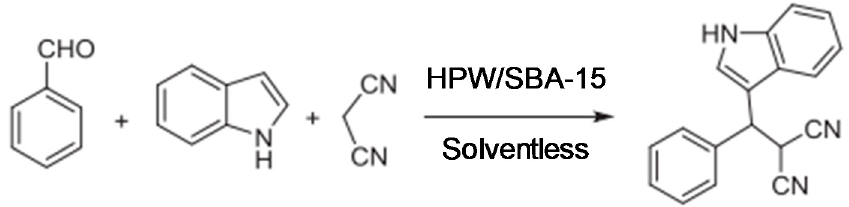
Scheme 1. General formulation for the preparation of 3-substituted indoles.